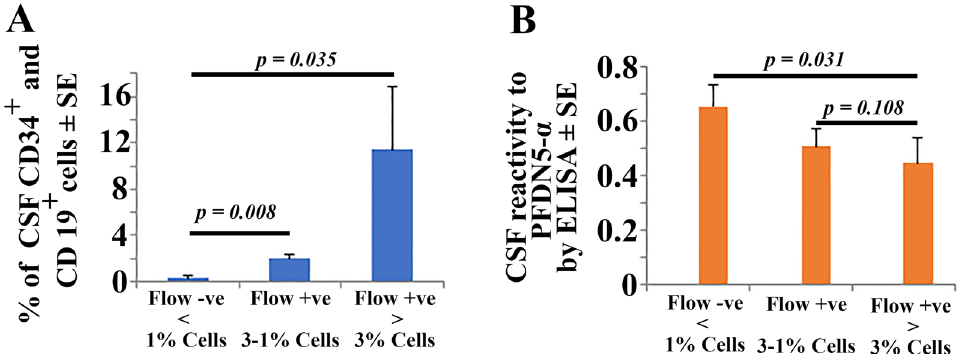
Figure 3. Validation Flow cytometry-based quantification of CD34 + /CD19 + cells in the CSF following initial gating with CD45 + and the extent of CSF reactivity of the same samples to PFDN5-α by ELISA quantification. Note that with increasing number of CD34 + /CD19 + cells ( A ), there is gradual decrease in reactivity of CSF to PFDN5-α identified by ELISA ( B ). More importantly, the CSF samples in which > 3% blast cells seen are statistically significant compared to CNS leukemia negative samples identified by flow (less than 1% CD34 + / CD19 + cells) and that the average CSF reactivity to PFDN5-α is 0.448 ± 0.092, a value below the cut off value of 0.456 identified by ROC curve